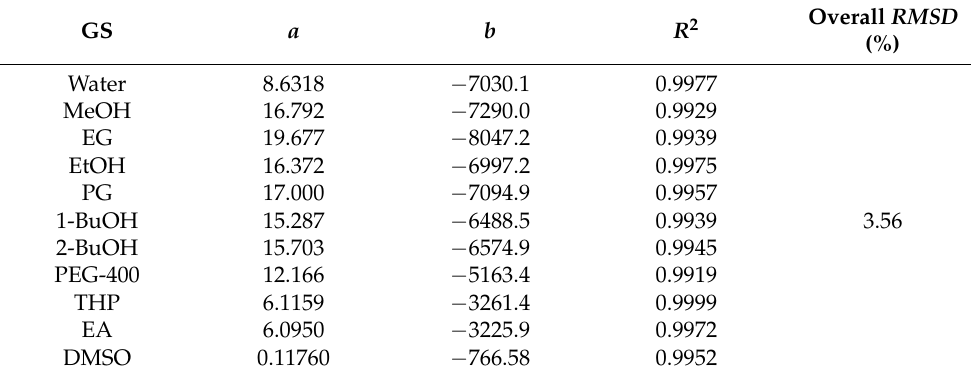
Table 5. ITN van’t Hoff model results in terms of model parameters ( a and b ), R 2 , and RMSD for eleven distinct green solvents.